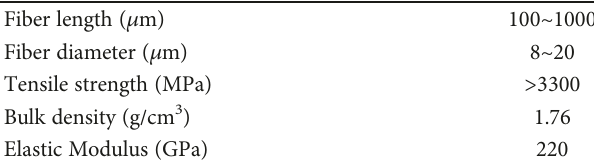
Table 3: Properties of carbon fi ber.